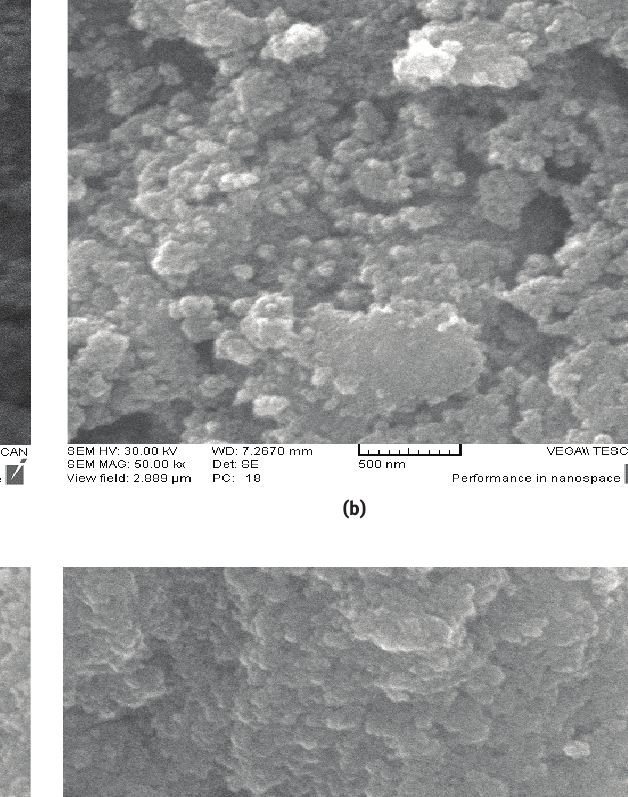
Figure 1: SEM images of Pr run 3, (c) run 5, and (d) run